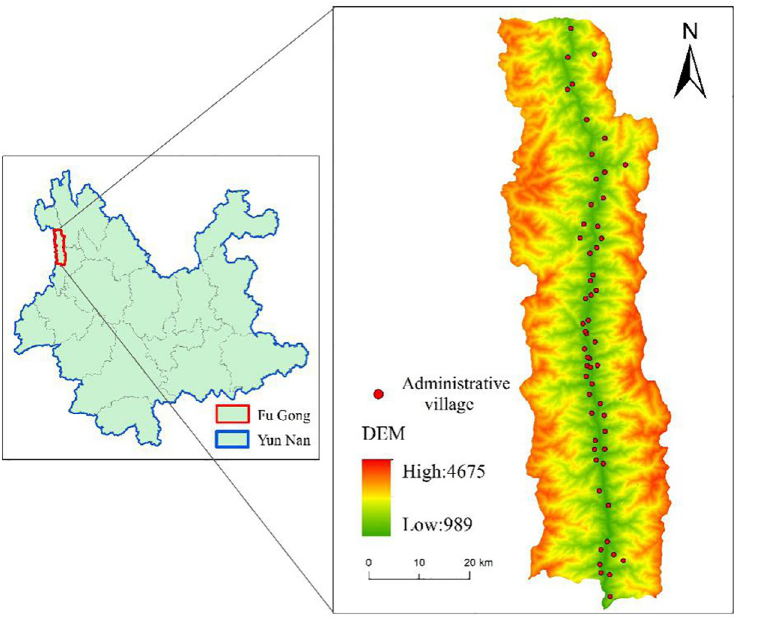
Fig 1. Overview of the study